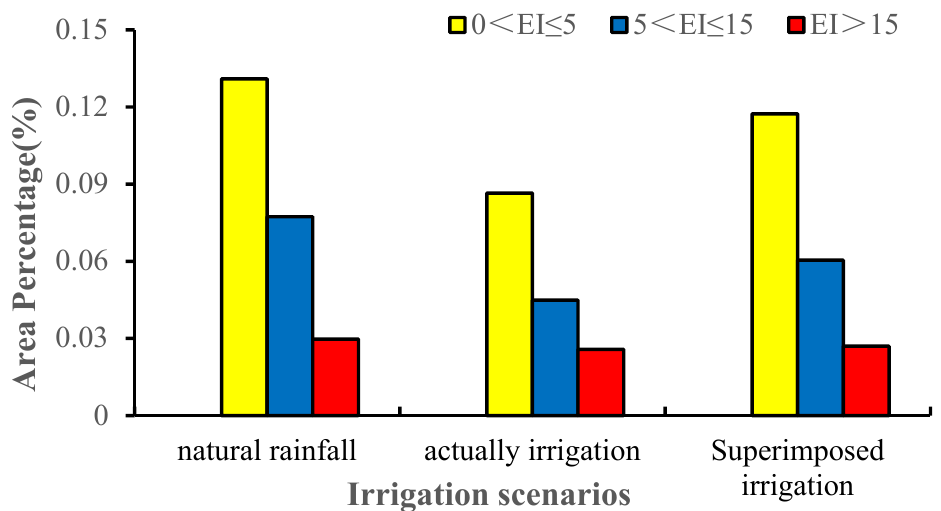
Figure 3. Changes in the potential distribution under historical climate conditions for two types of irrigation.